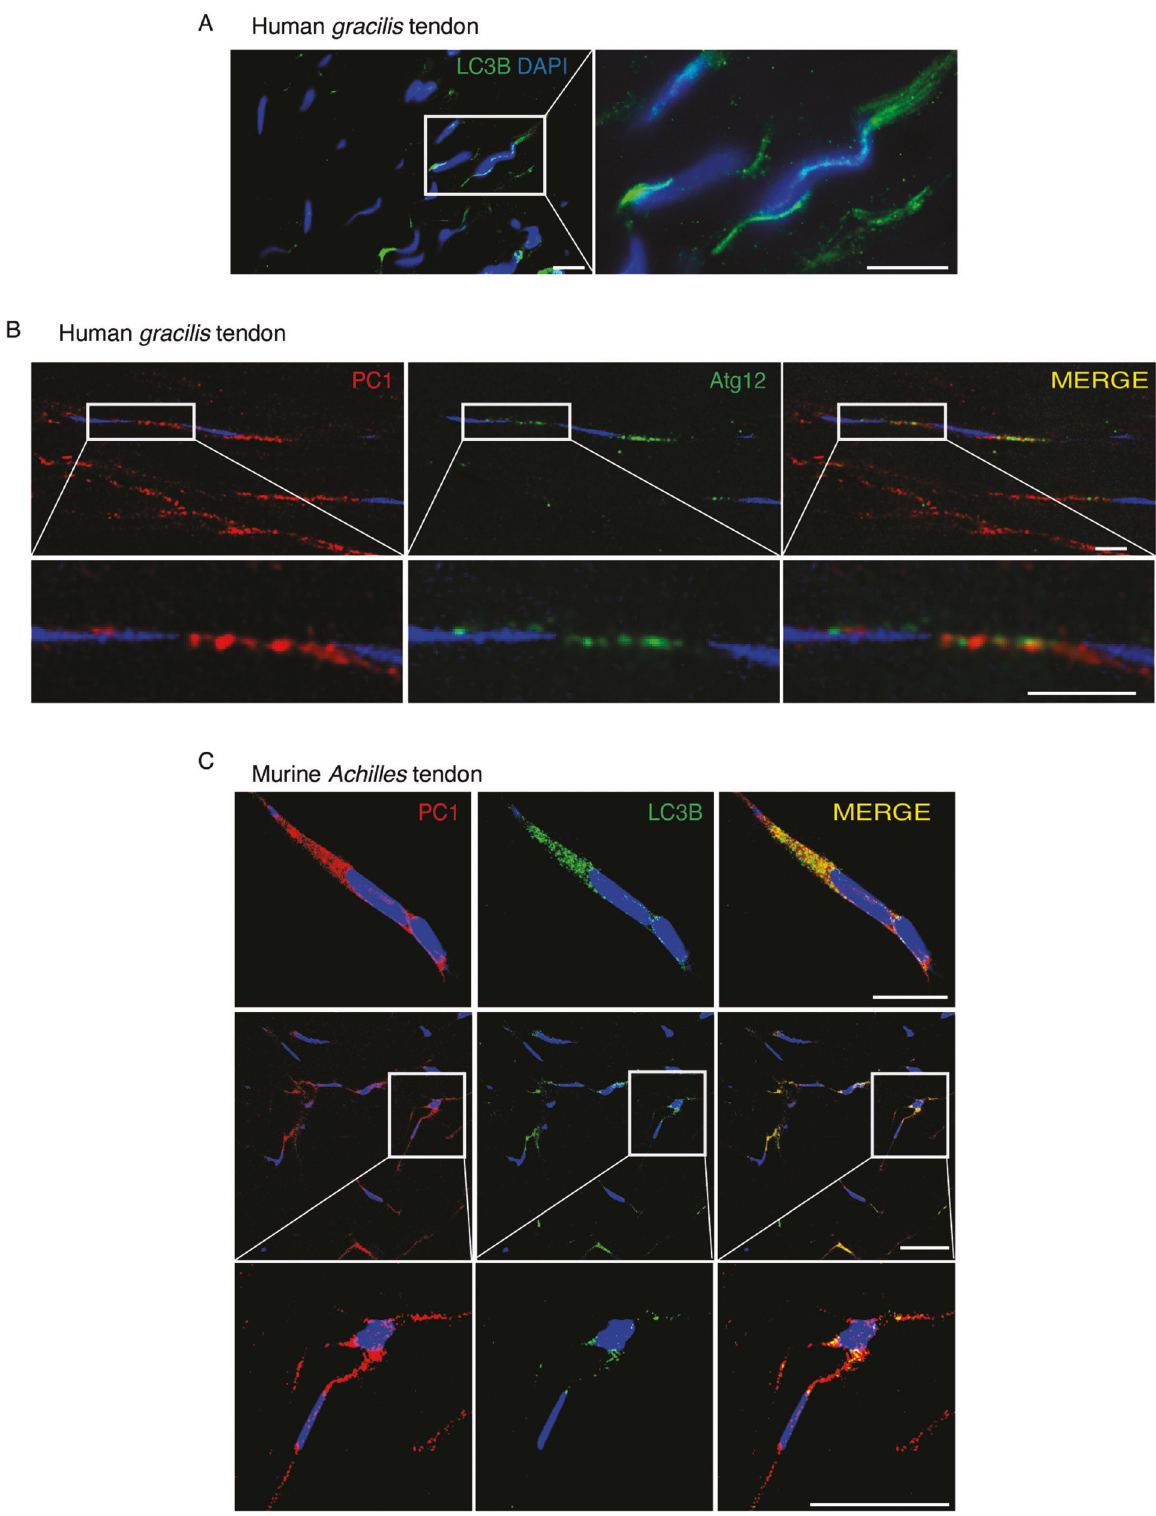
Fig. 1 Autophagy degrades PC1 in tendons. A Representative images of LC3B puncta (autophagosomes) in human gracilis tendon. Human tendon tissues were immunolabeled for LC3B (green), nuclei stained with DAPI (blue) and analyzed by confocal microscopy. Scale bar = 10 μ m. Inset shows a higher magni fi cation of selected areas. B Representative images of human gracilis tendon immunolabeled for PC1 (red), Atg12 (green) and nuclei stained with DAPI (blue). Tissues were analyzed by confocal microscopy. Scale bars = 10 μ m. The insets show higher magni fi cation and single color channels of the boxed areas. C Representative images of murine Achilles tendons immunolabeled for PC1 (red), LC3B (green) and nuclei stained with DAPI (blue). Tissues were analyzed by confocal microscopy. Scale bars = 10 μ m. The insets show higher magni fi cation and single color channels of the boxed areas.